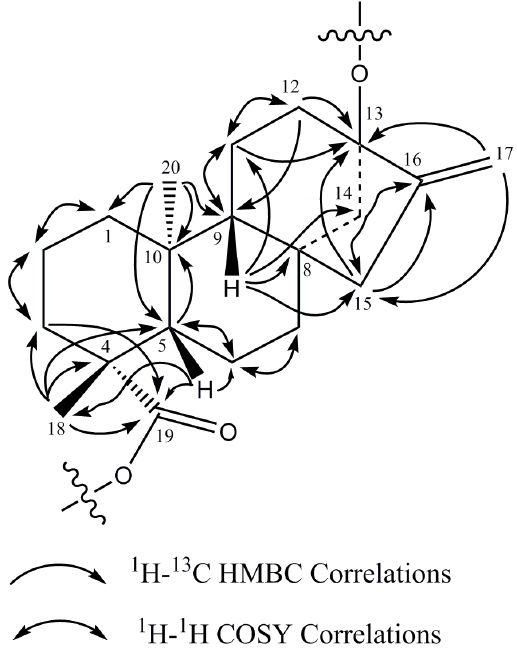
Figure 4. 1 H- 1 H COSY and 1 H- 13 C HMBC correlations of the diterpene core of rebaudioside I